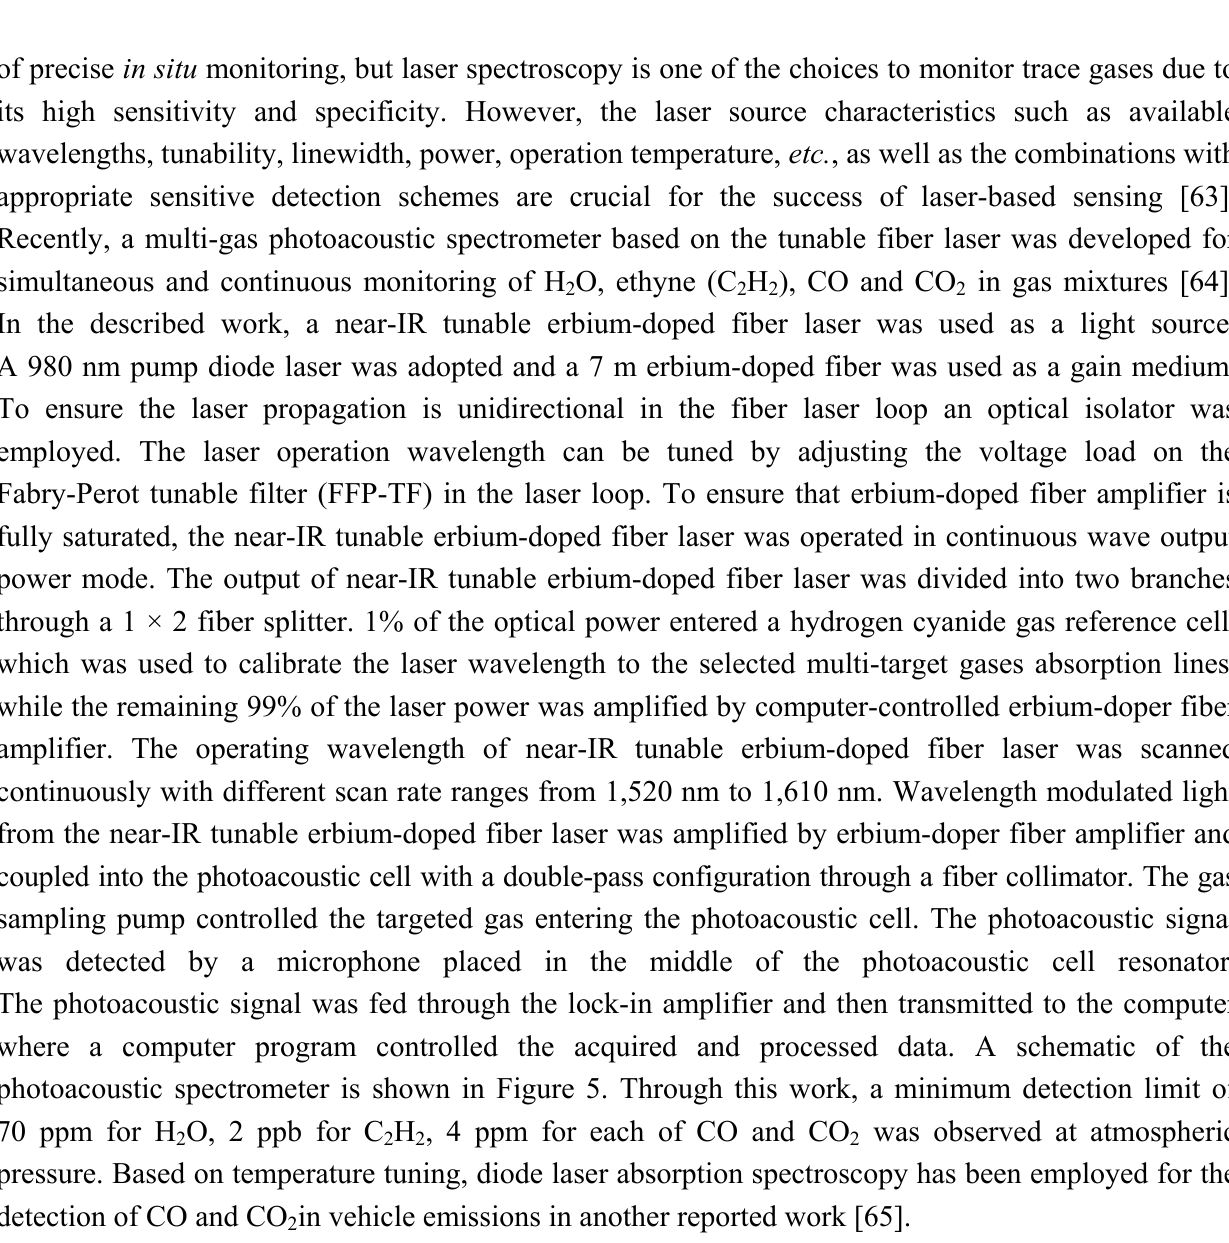
Figure 5. The schematic of photoacoustic spectrometer [64], reproduced by the permission of